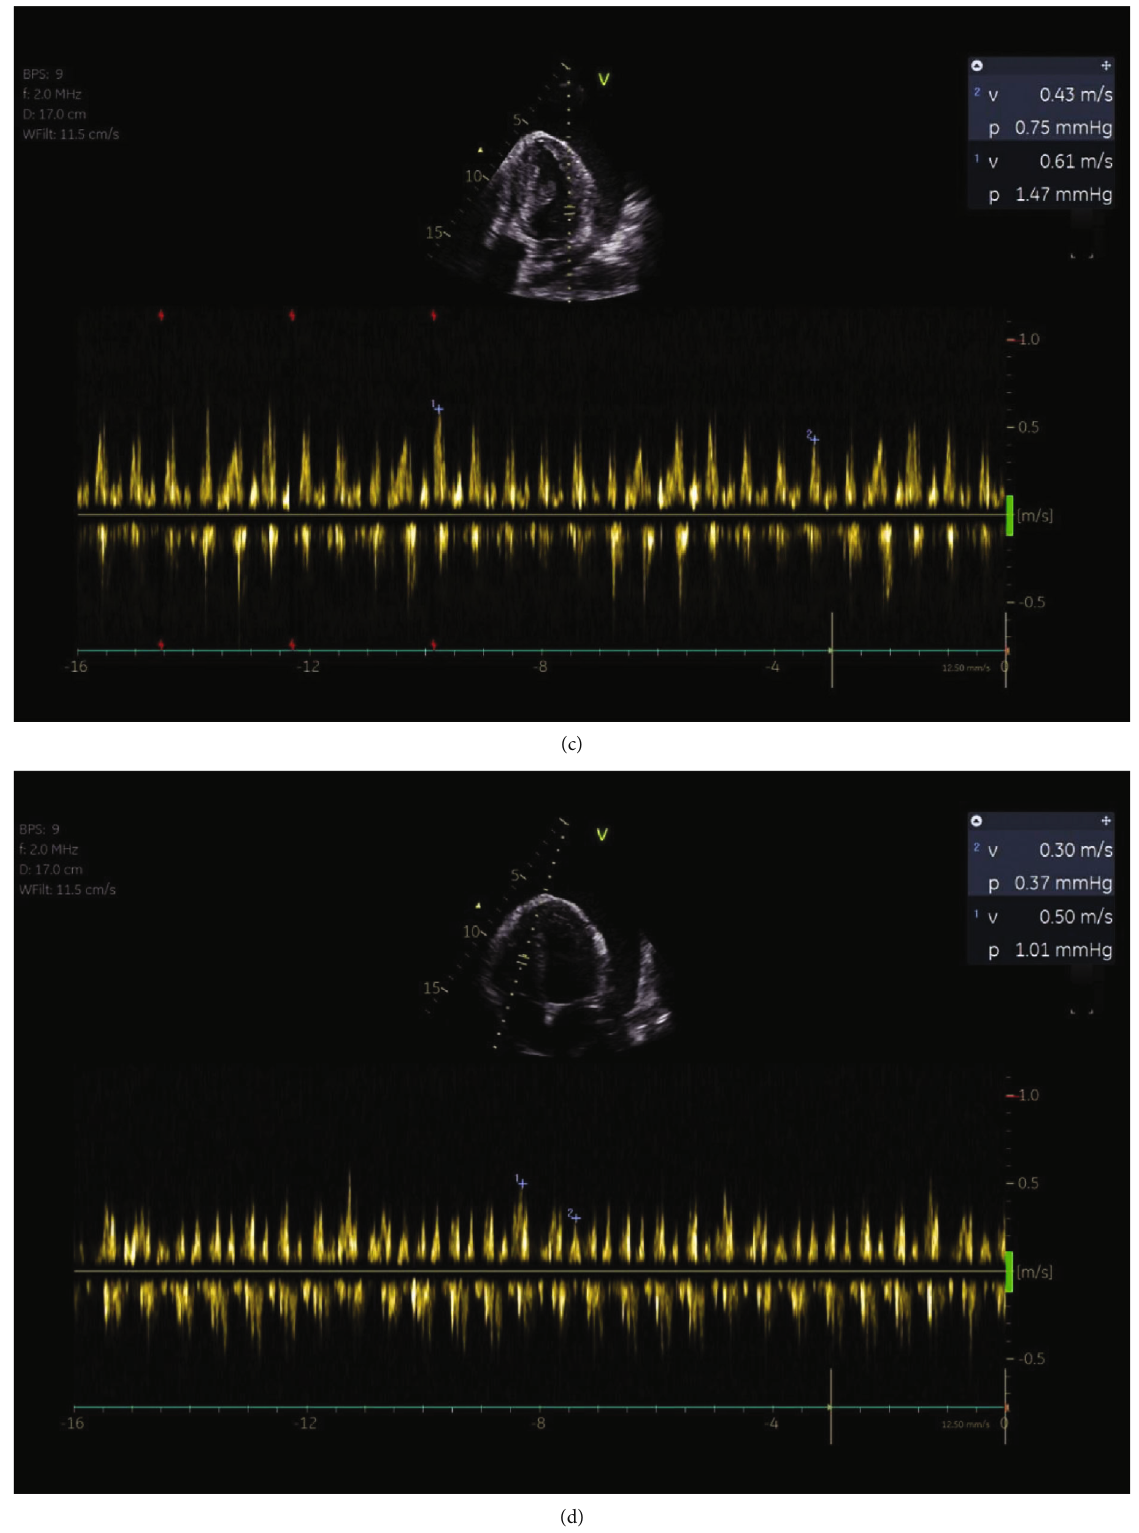
Figure 2: Initial transthoracic echocardiography indicating pericardial tamponade. (a) Apical 4-chamber view with large circumferential pericardial e ff usion. (b) Apical 4-chamber view (M-mode) with 4.89mm pericardial e ff usion end diastolic. (c) Mitral in fl ow respiratory variation > 25 % and (d) tricuspid in fl ow respiratory variation > 40 % by PW-Doppler indicating tamponade morphology; scale and velocity settings are not optimal due to intensive care unit bedside